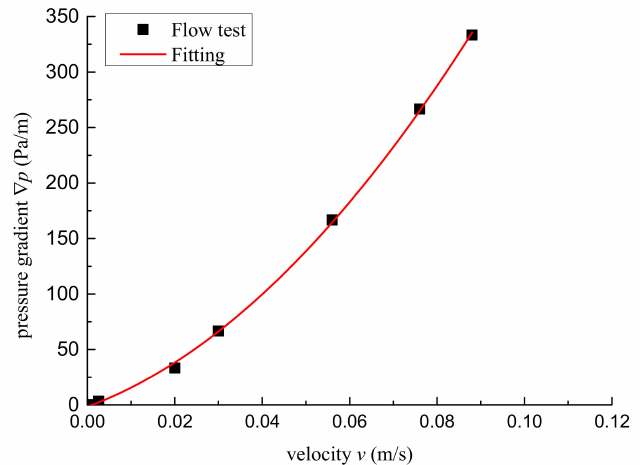
Figure 16. The relationship between the flow velocity and the pressure gradient for the sandstone specimen with 18 internal fractures and 28 fracture intersections